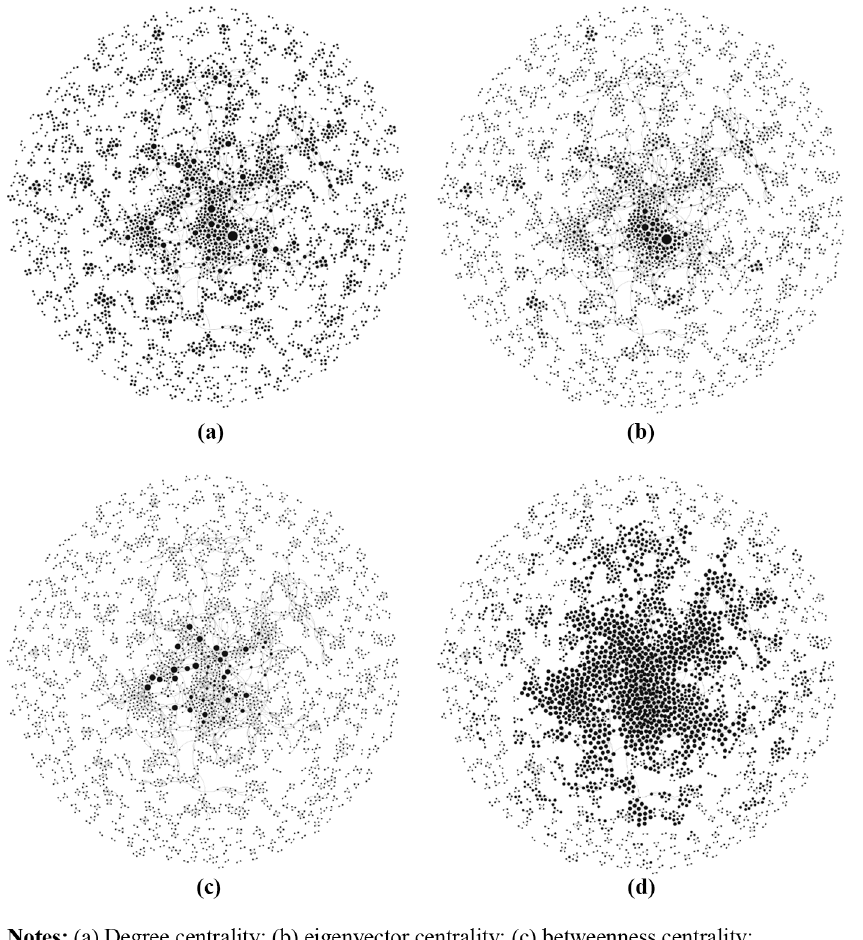
Figure 2. Ranking of node